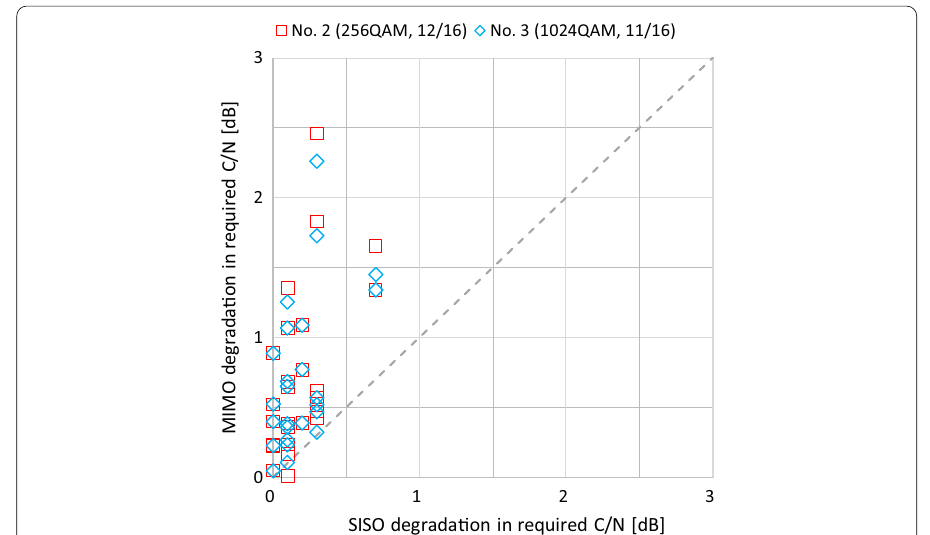
Fig. 20 Comparison of degradation in required C / N between SISO and MIMO for each MIMO channel snapshot compared with required C / N in AWGN channel in laboratory experiments